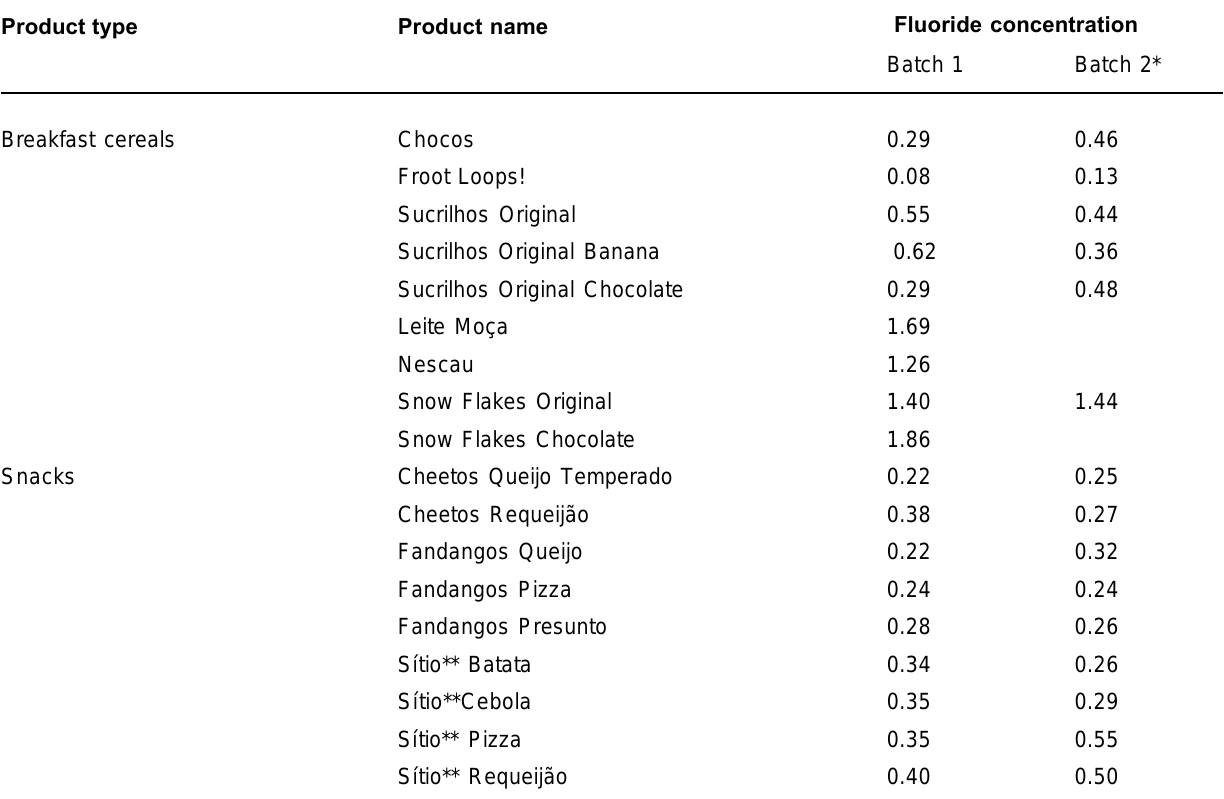
TABLE 2 - Fluoride content (mean unit µg/g) of breakfast cereals and snacks in two different dates of manufacturing (different